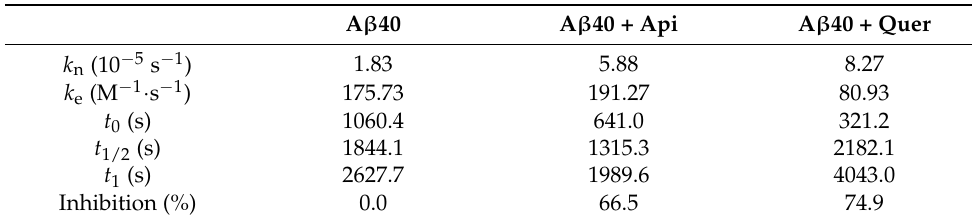
Note: [A β 40] = 20 µ M; [Quercetin/Apigenin] = 20 µ